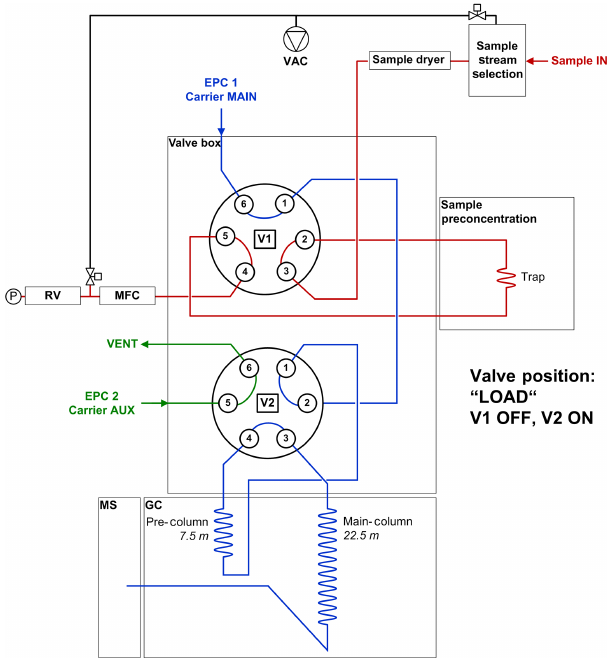
Figure 1. Flow scheme showing the gas flow during preconcentra- tion. Two electronic pressure controllers, EPC 1 and EPC 2, control the carrier gas flow. The two 6-port 2-position rotary valves V1 and V2 are set to OFF/ON position. A sample is preconcentrated (red flow path); sample components not trapped flow through the mass flow controller (MFC) into the reference volume (RV). By switch- ing V1 to ON position, the preconcentration trap is injected onto the GC column. The trap as well as reference volume and stream selec- tion valves are evacuated prior to the preconcentration of the next sample. By switching V2 to OFF, it separates the pre-column and main column; the pre-column is flushed backwards. This prevents high-boiling, non-targeted species from reaching the main